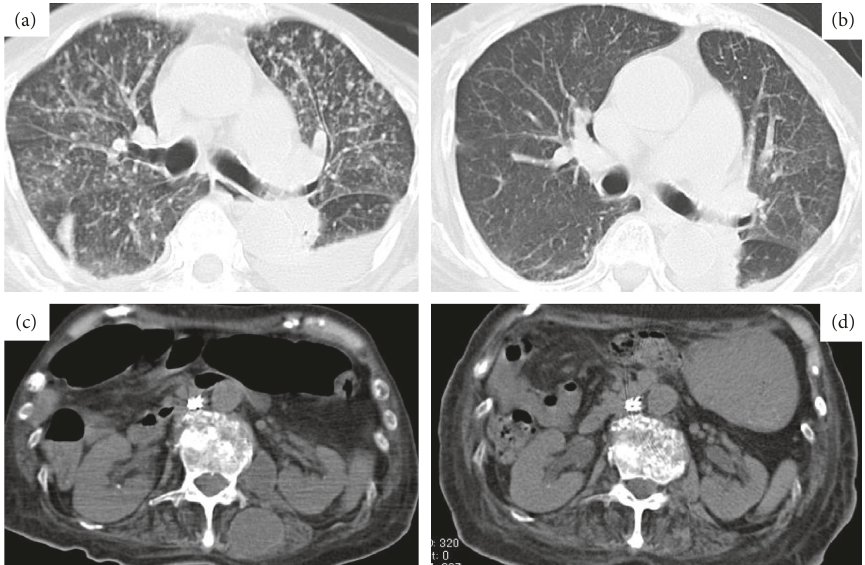
Figure 2: Computed tomography scan images of case 1. Particulate lesions diffusely observed in both lung fields (a) were diminished after antituberculosis therapy (b); cystic lesion with the same absorption range as abscess observed in paraspinal muscle (c) was also diminished after antituberculosis therapy